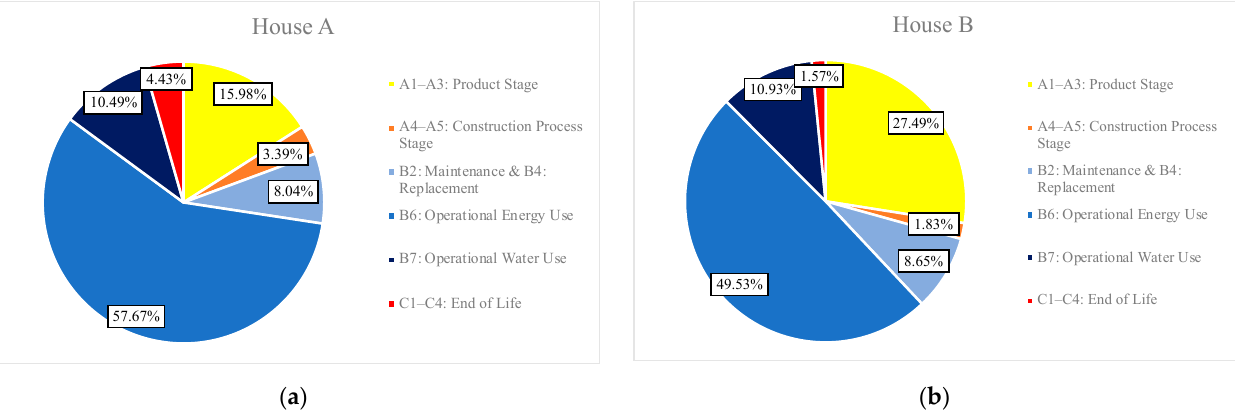
Figure 6. Carbon emissions from the buildings during their life stages: ( a ) light timber house (House A); ( b ) light steel house (House B).